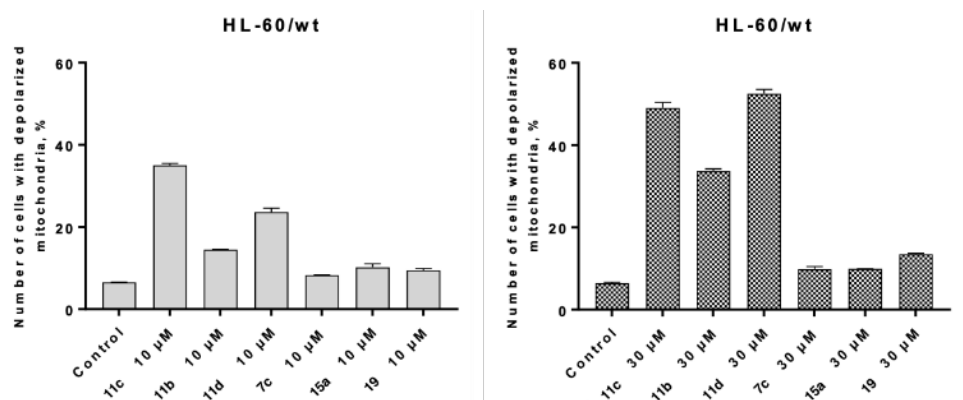
Figure 9. Depolarization of mitochondria in HL-60 / wt cells under the action of selected CK2-HDAC dual inhibitors (10 µ M and 30 µ M, 24 h) was determined by FACS using the Mitochondrial Membrane Potential Assay JC-1. One of three experiments delivering comparable data is shown.